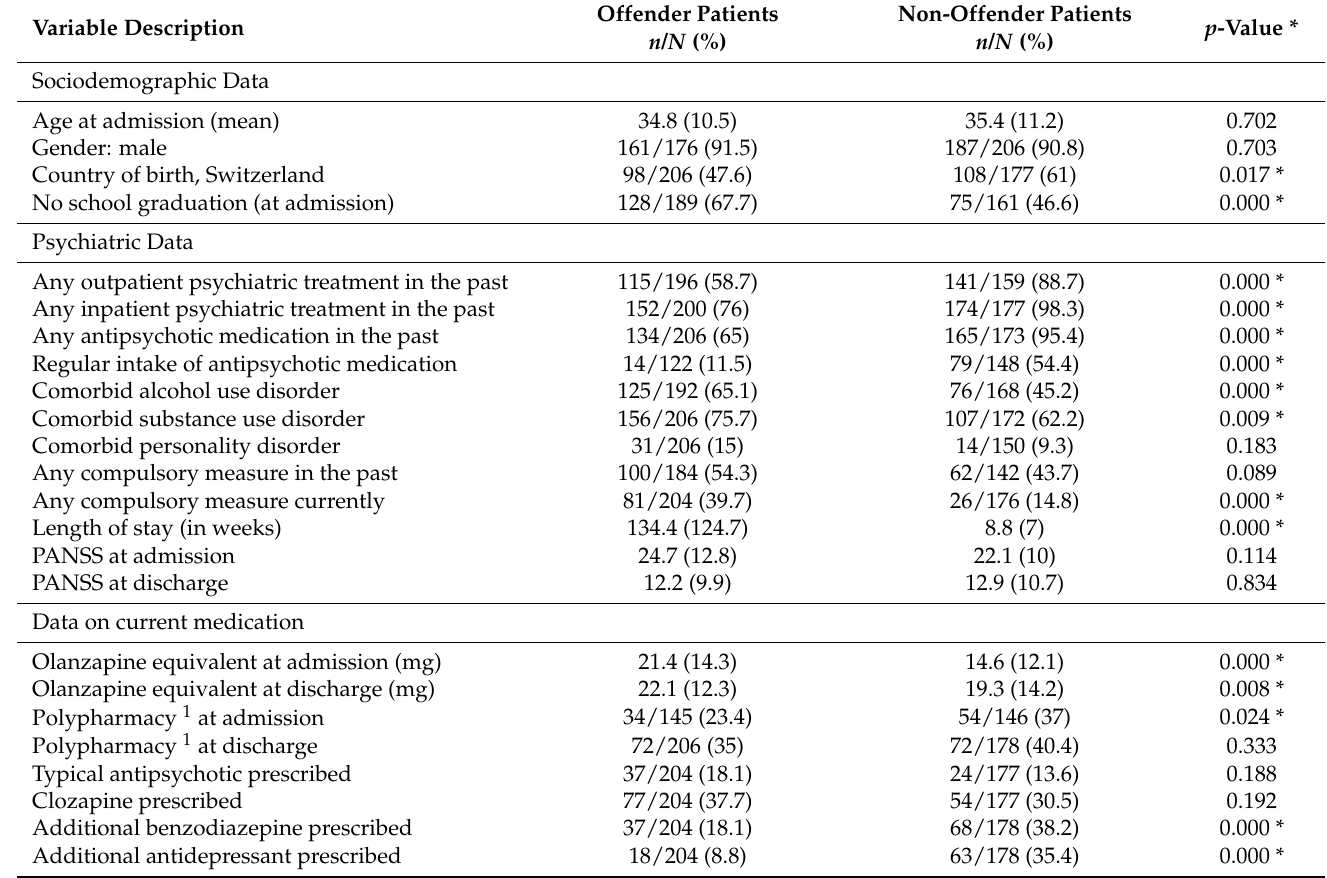
Table 1. Absolute and relative distributions of predictor variables and levels of significance in